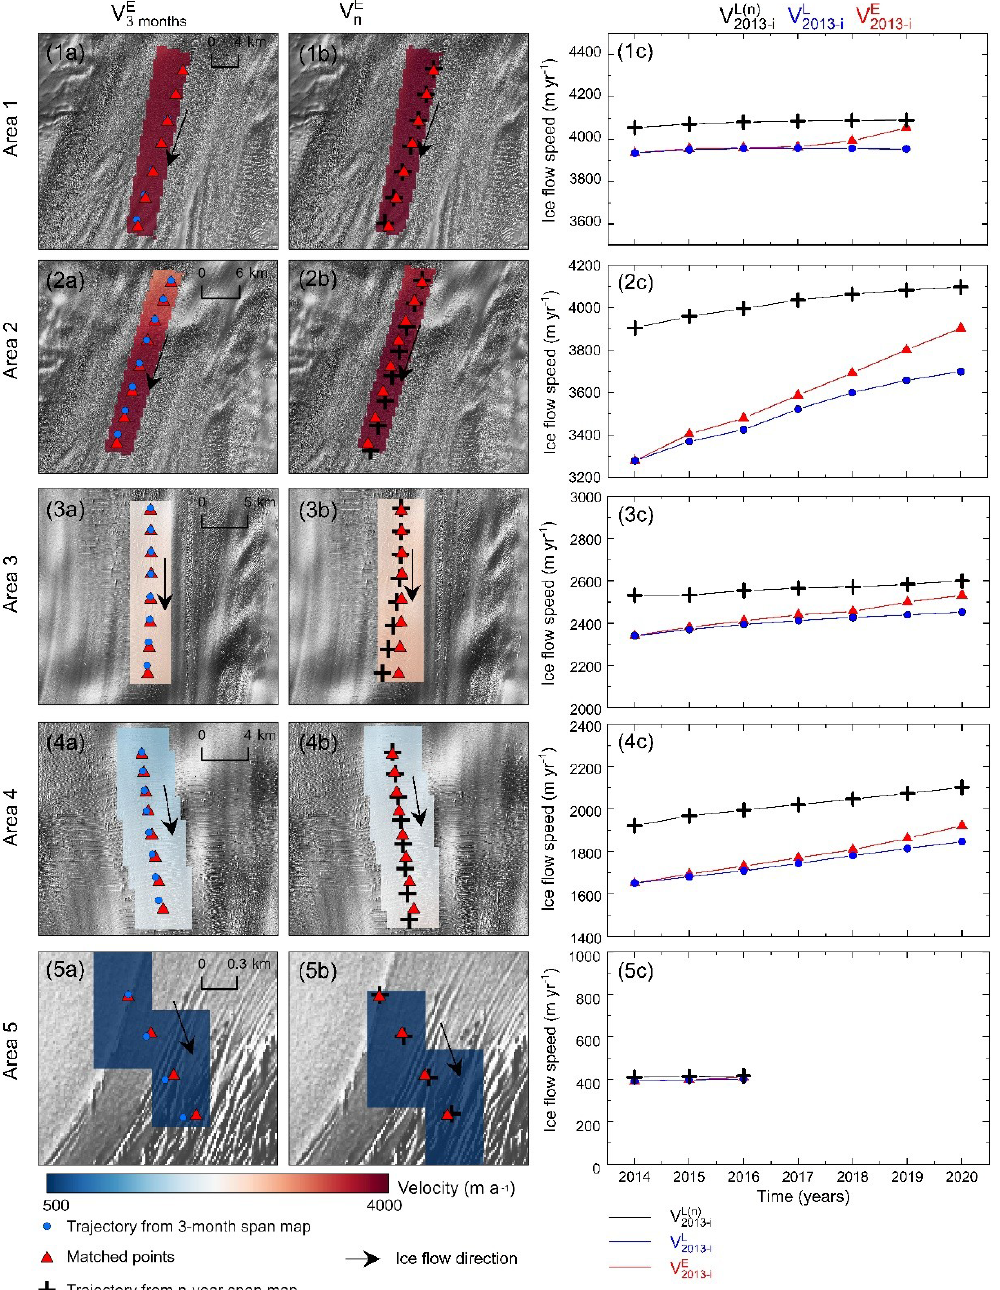
Figure A3. Velocities in five areas (numbered yellow rectangles in Fig. 3) of PIG are used to demonstrate application of the OE correction method. Panels (1a) – (5a) show the reconstructed 3-month velocity maps V 2013–2014 in the areas; matched points (red triangles) are used to ( i = 2014 (3 months), 2015, ... , n ) (red lines in panels 1c – 5c ); points along the flow line (blue dots) are tracked map E velocity V E 2013– i (blue lines in panels 1c – 5c ). Similarly, panels (1b) – (5b) illustrate the from the 3-month maps and used to calculate L velocity V L 2013– i reconstructed n -year velocity maps V 2013– n in the areas with the matched points (red triangles) for E velocity V E(n) ; points along the flow 2013– i line (black crosses) are tracked from the n -year-span velocity map and used to calculate L velocity V L(n) (black lines in panels 1c – 5c ). 2013– i In each area (panels 1c – 5c ) the difference between red and blue lines increases with time; the black line is above the blue line due to the spatial-acceleration-induced OE over n -year span, but they are relatively parallel, and thus a correction can be estimated. Background in panels (1a) – (5a) and (1b) – (5b) is Landsat 8 image of 12 February